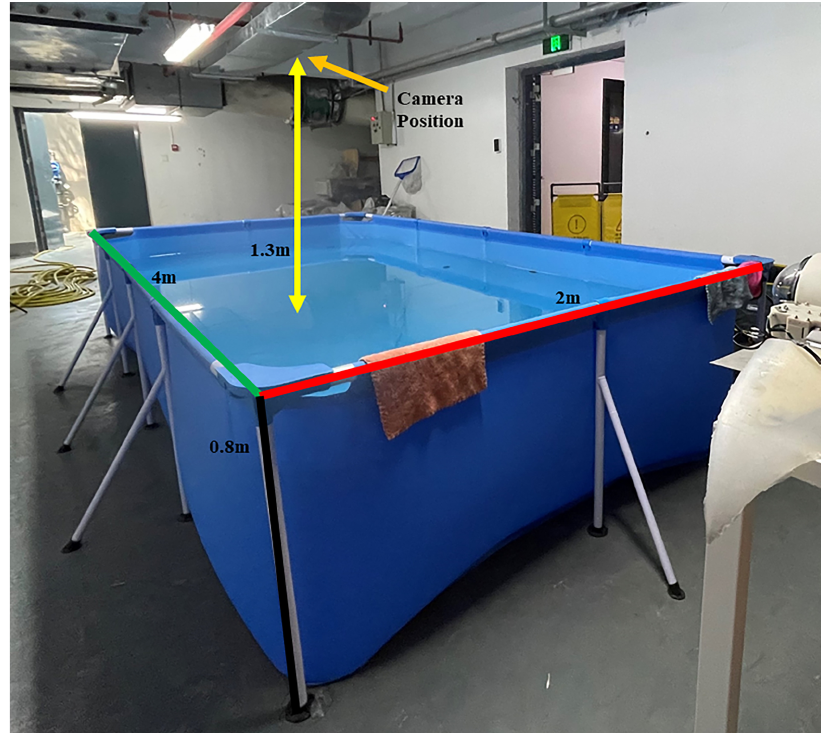
Figure 14. The swimming pool used in the